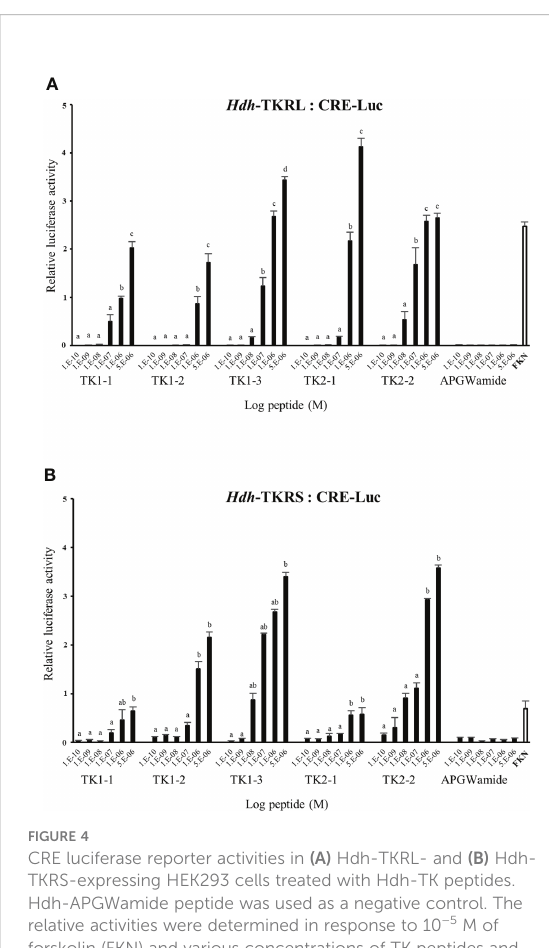
FIGURE 4 CRE luciferase reporter activities in (A) Hdh-TKRL- and (B) Hdh- TKRS-expressing HEK293 cells treated with Hdh-TK peptides. Hdh-APGWamide peptide was used as a negative control. The relative activities were determined in response to 10 − 5 M of forskolin (FKN) and various concentrations of TK peptides and APGWamide. The relative reporter activities are presented as the mean ± SEM (n = 3). Lower case letters indicate statistically signi fi cant differences (p < 0.05).